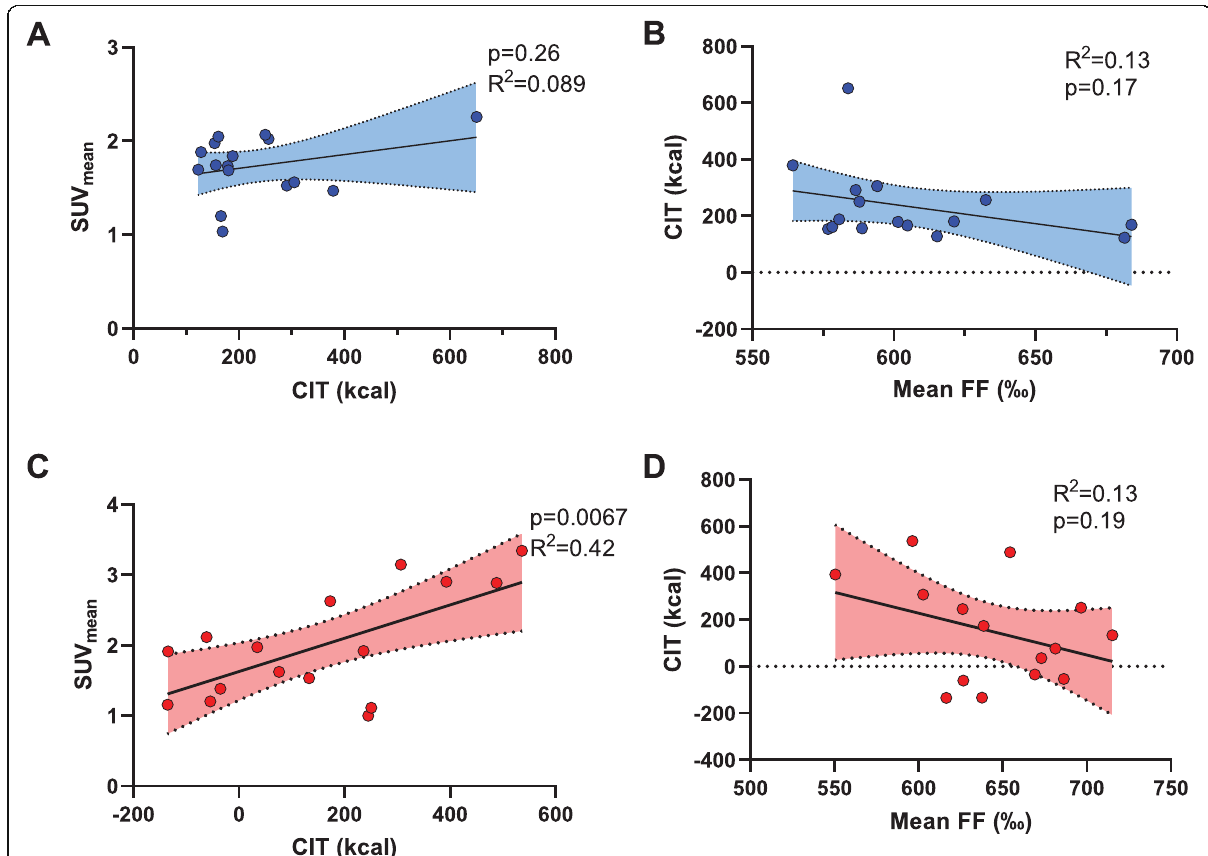
Fig. 6 Linear regression of FDG uptake versus cold-induced thermogenesis (CIT) and fat fraction versus CIT in cohort 1 ( a and b ) and cohort 2 ( c and d